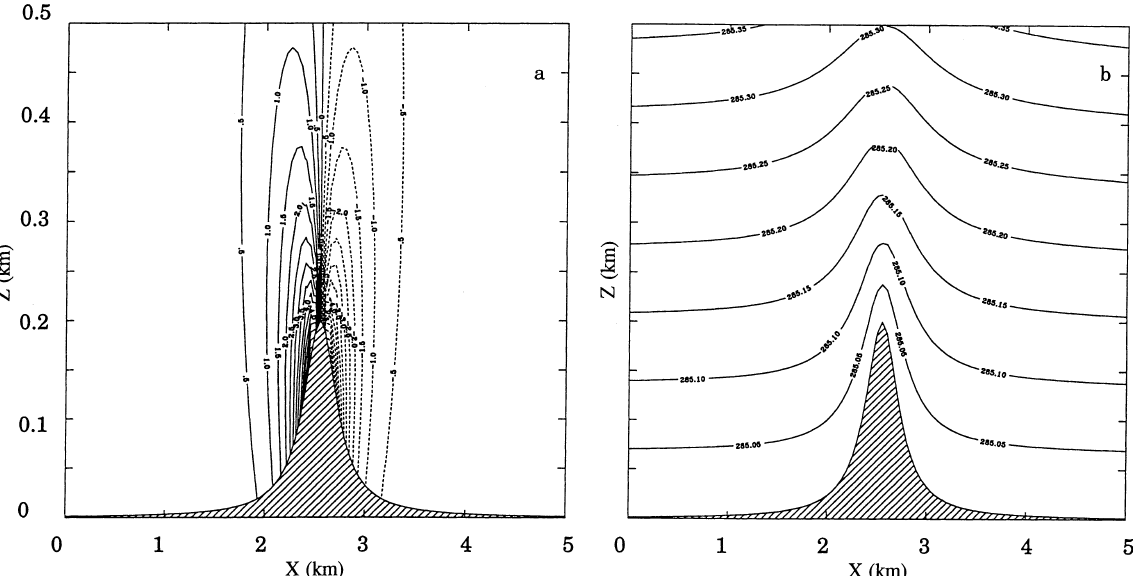
Fig. 4a,b. Solution obtained by the model for the nearly potential flow field used in the test of the advection scheme. a Vertical velocity, contour interval 0 : 5ms (cid:255) 1 ; b potential temperature, contour interval 0 : 05K. The coordinate lines are labelled